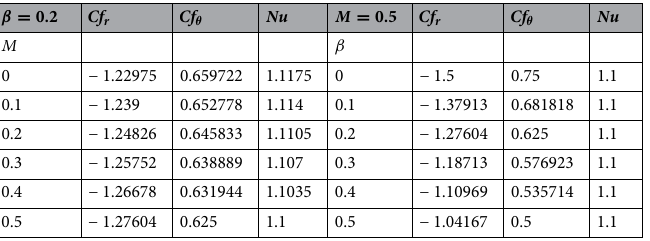
Table 1. Skin friction along the radial and tangential direction and Nusselt number for some values of the magnetic parameter M and the material parameter β .